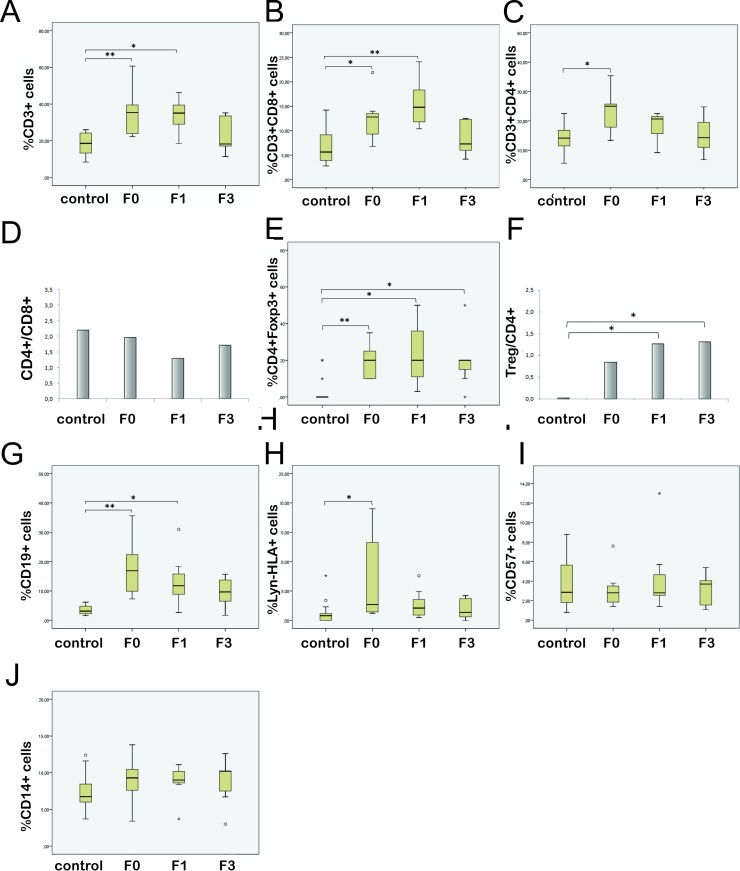
Flow cytometric analysis of peripheral blood mononuclear cells in healthy controls and patients in different stages of fibrosis (F0, F1, F3).The box plots present percentage of respective PBMNC populations in controls and patients: (A) total T lymphocytes, (B) cytotoxic, (C) helper and (E) regulatory T lymphocytes, (G) B lymphocytes, (H) dendritic cells, (I) NK cells and (J) CD14+ cells. The bar graphs show average CD4/CD8 ratio (D) and the percent of Treg cells in CD4+ population (F). Asterisk reflects significance of difference related to control: *p<0.05; **p<0.001.